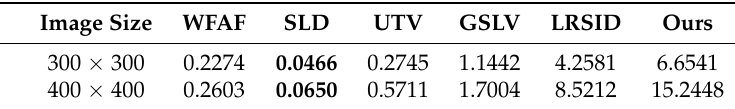
Table 5. The computational cost of the